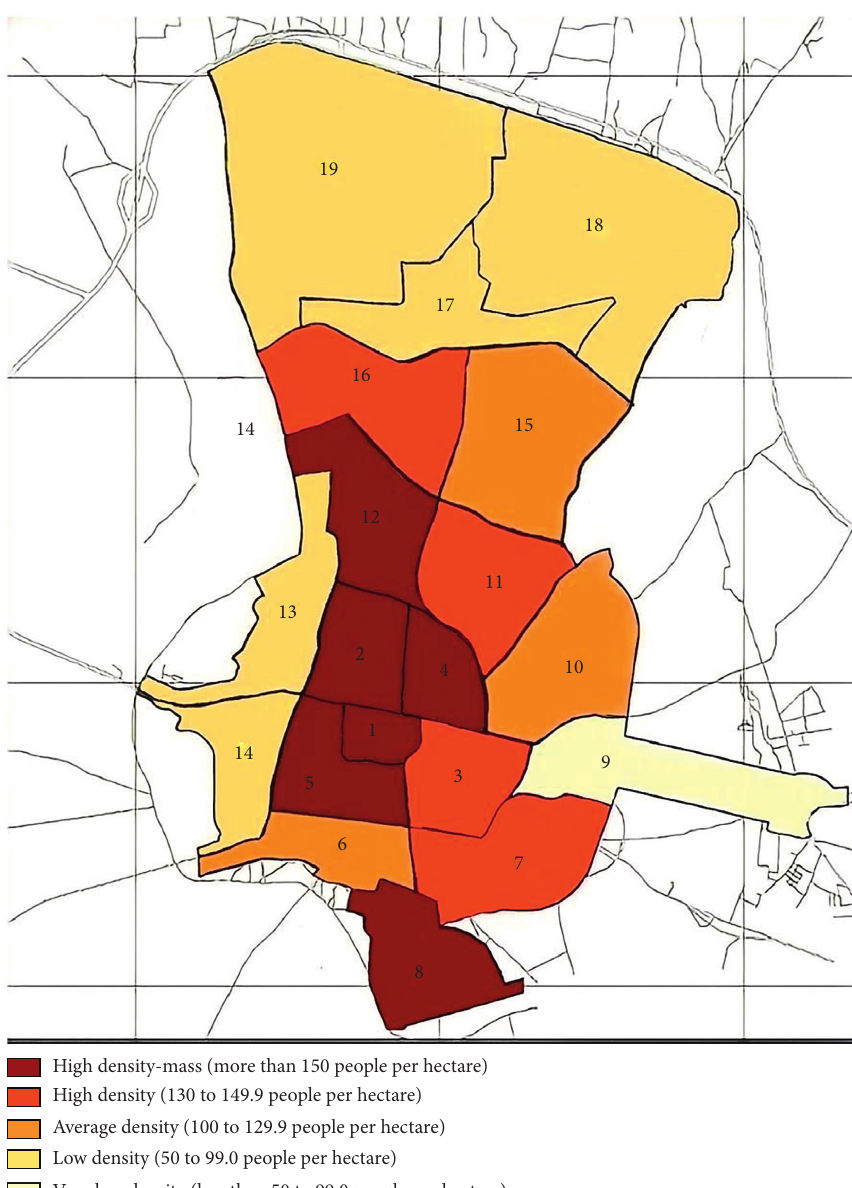
Figure 6: Population density map of Qazvin city